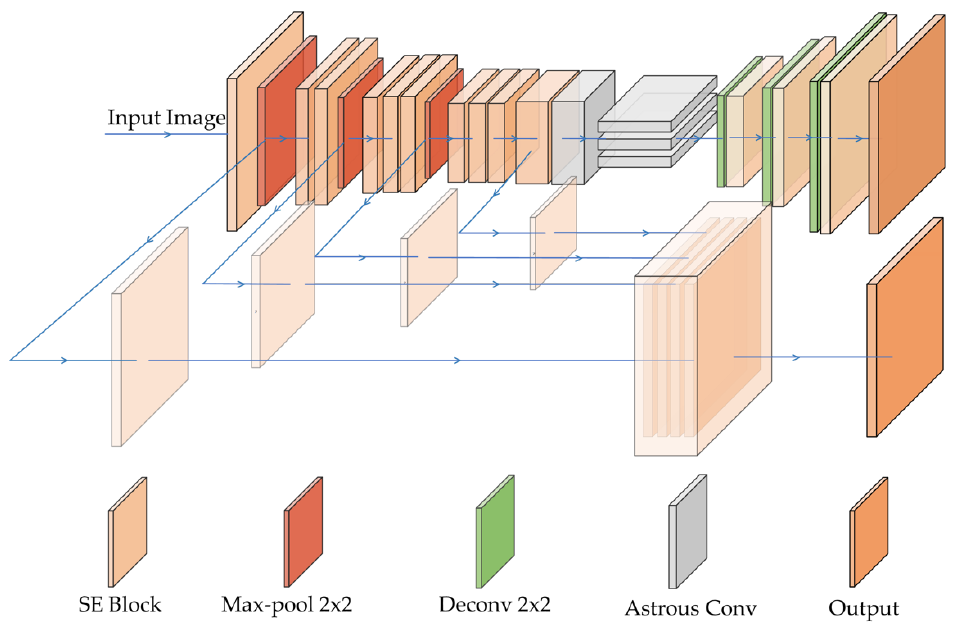
Figure 3. The structure of the proposed model (Nested SE-Deeplab) for road extraction from very-high-resolution remote sensing images.